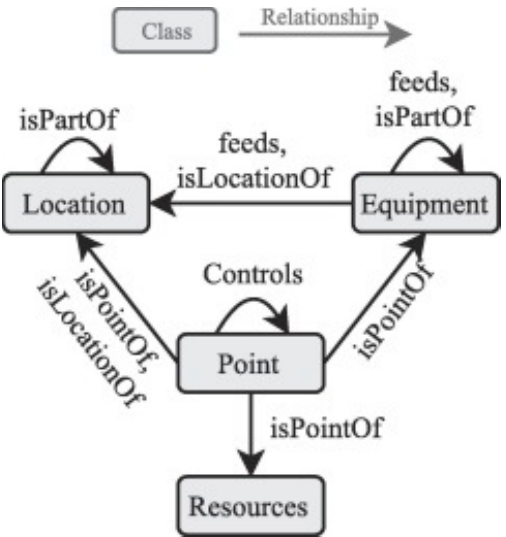
Figure 7. Information concepts in Brick and their relationship to a data point [132] (Reprinted from